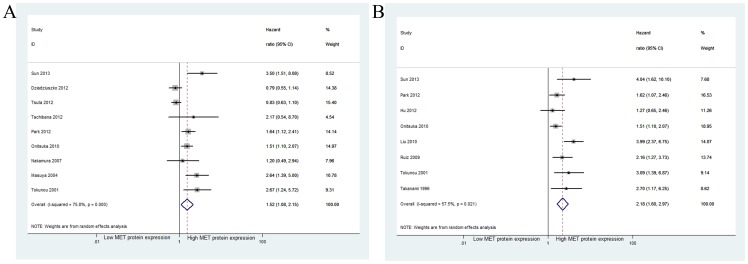
Meta-analysis of effects of the MET protein expression on overall survival of patients with NSCLC.Forest plot showing (A) the combined relative HR for OS by univariate analysis; (B) the combined relative HR for OS by multivariate analysis.